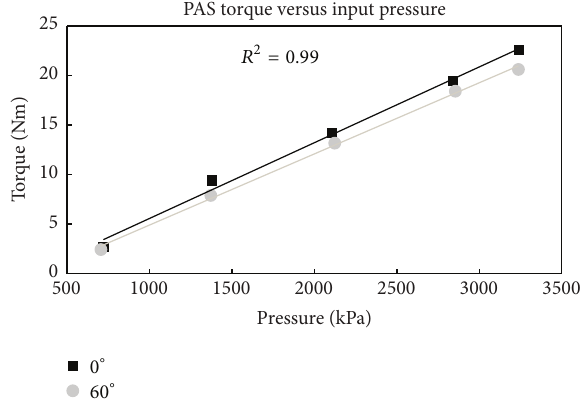
Figure4:Outputisometrictorqueasafunctionofsuppliedpressure at 0 and 60 ∘ of hip flexion. 𝑅 2 of 0.99 is representative of both